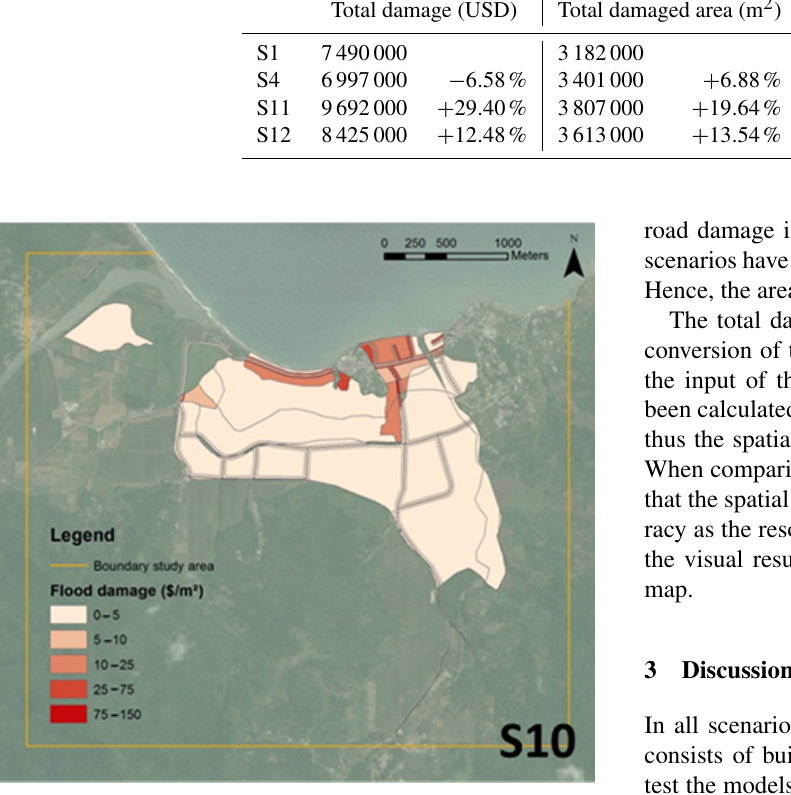
Figure 7. Damage map for Annotto Bay for S10. (Difference be- tween banana plantains and other crops is